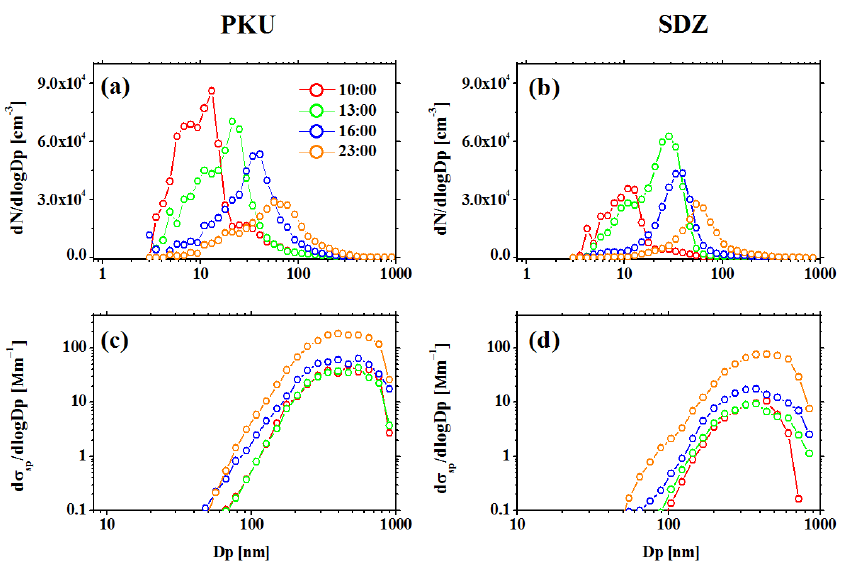
Fig. 5. Evolutions of (a, b) the particle number size distributions measured by TDMPS and (c, d) the simulated particle light scattering size Figure 5. Evolutions of ( a&b ) the particle number size distributions measured by TDMPS and ( c&d ) the 855 distributions at 550nm from about 10:00 (local time) to midnight (23:00) on 26 September 2008. Left and right panels represent the PKU simulated particle light scattering size distributions at 550 nm from about 10:00 (local time) to midnight (23:00) on 856 and SDZ sites, September 26, 2008. Left and right panels represent the PKU and SDZ sites, respectively. 857